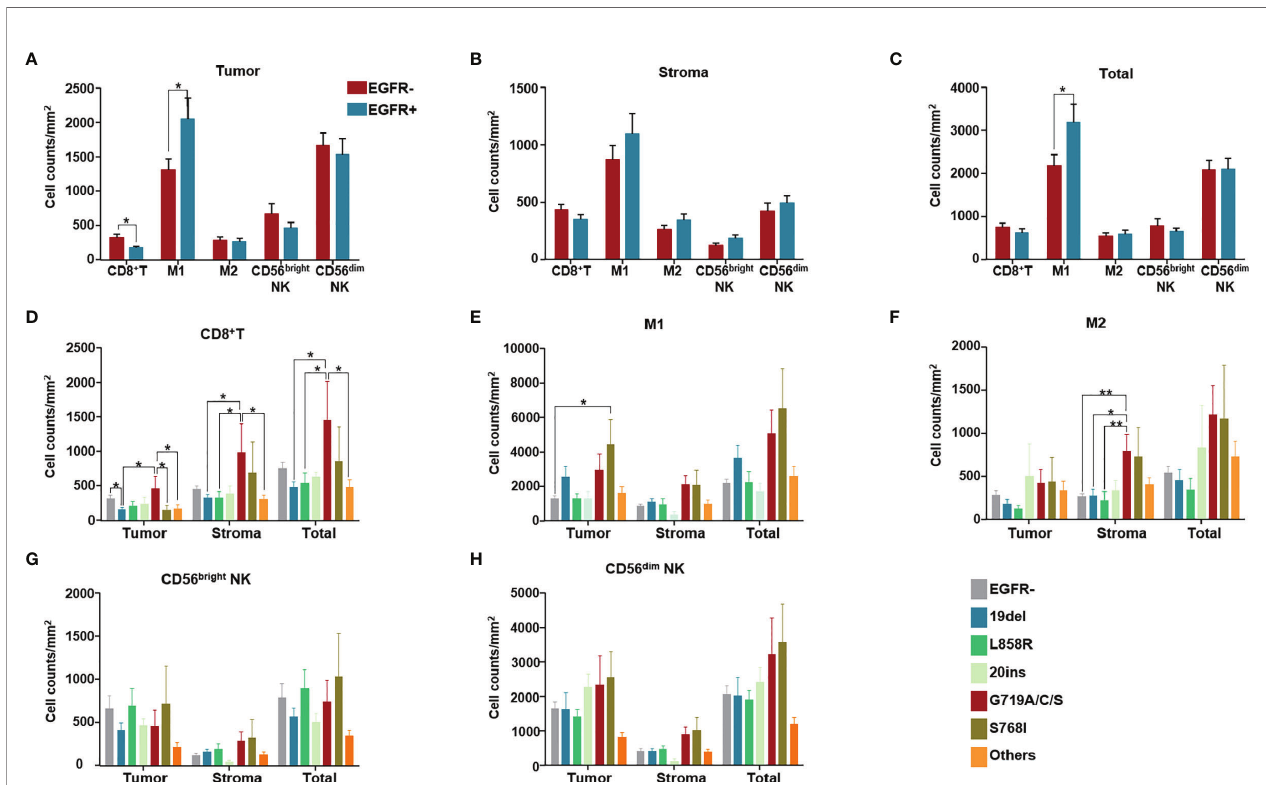
FIGURE 4 | Immune cell counts both in tumor (intra-tumoral region) and stroma of 154 NSCLC patients. Immune cell counts both in tumor (intra-tumoral region) and stroma of 154 NSCLC patients of EGFR wild type and with different EGFR mutation subgroups. (A) Numbers of different immune cells in tumor were compared between without and with EGFR mutation groups. (B) Numbers of different immune cells in stroma were compared between without and with EGFR mutation groups. (C) Numbers of different immune cells in total (stroma and tumor) were compared between without and with EGFR mutation groups. (D – H) Numbers of CD8 + T cells, M1, M2 TAM, CD56bright NK cells, CD56dim NK cells in tumor, stroma, in total (tumor and stroma) were compared among patients of different EGFR mutation subgroups. (in the group termed as “ other uncommon mutations ” , contained EGFR ampli fi cation, EGFR p.E709A, EGFR p.E709K, EGFR p.E709V, EGFR p.F254L, EGFR p.H773dup, EGFR p.H870R, EGFR p.I740_K745dup, EGFR p.L747P, EGFR p.N468K, EGFR p.R451H, EGFR p.R776C, EGFR p.R776L and EGFR p.S768_D770dup). *means p < 0.05, **means p <